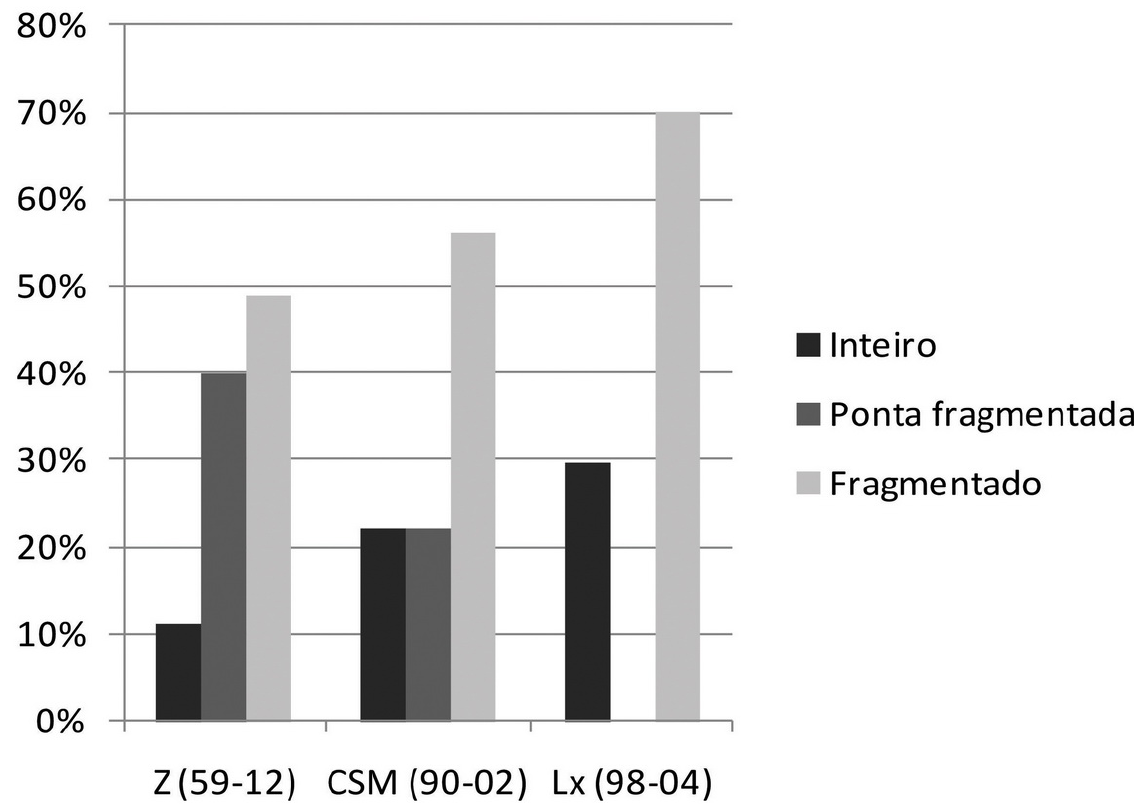
Figura 3. Estado de conservação das pontas de seta: inteiro; ponta fragmentada e fragmentado - Zambujal 1959- 2012 (Z), S. Mamede 1991-2002 (CSM) e Penedo do Lexim 1998-2004 (Lx). Figure 3. Arrow point conservations status: complete; broken only in the tip; broken - Zambujal 1959-2012 (Z), S. Mamede 1991-2002 (CSM) e Penedo do Lexim 1998-2004 (Lx).